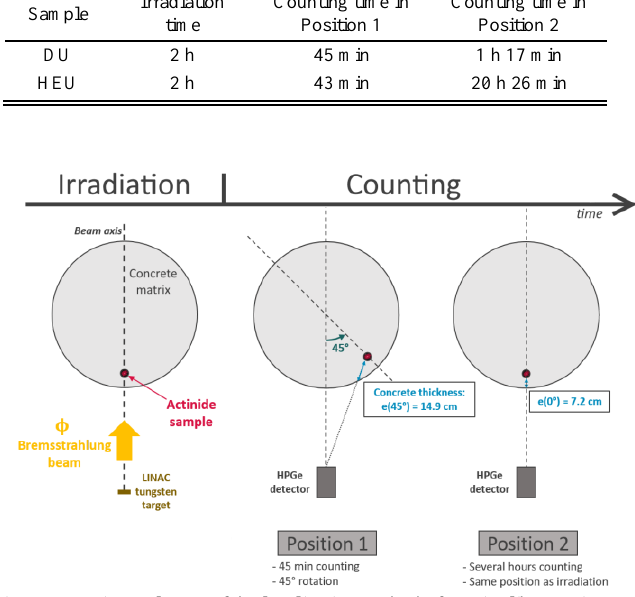
Fig. 3. Experimental steps of the localization method of a point-like uranium sample in a concrete matrix.